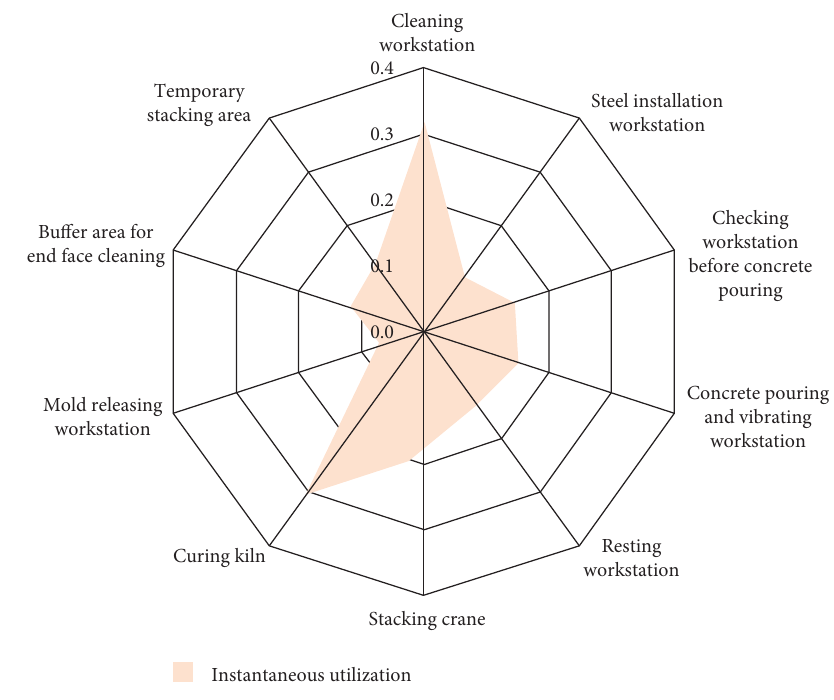
Figure 9: Average instantaneous utilization of each workstation.